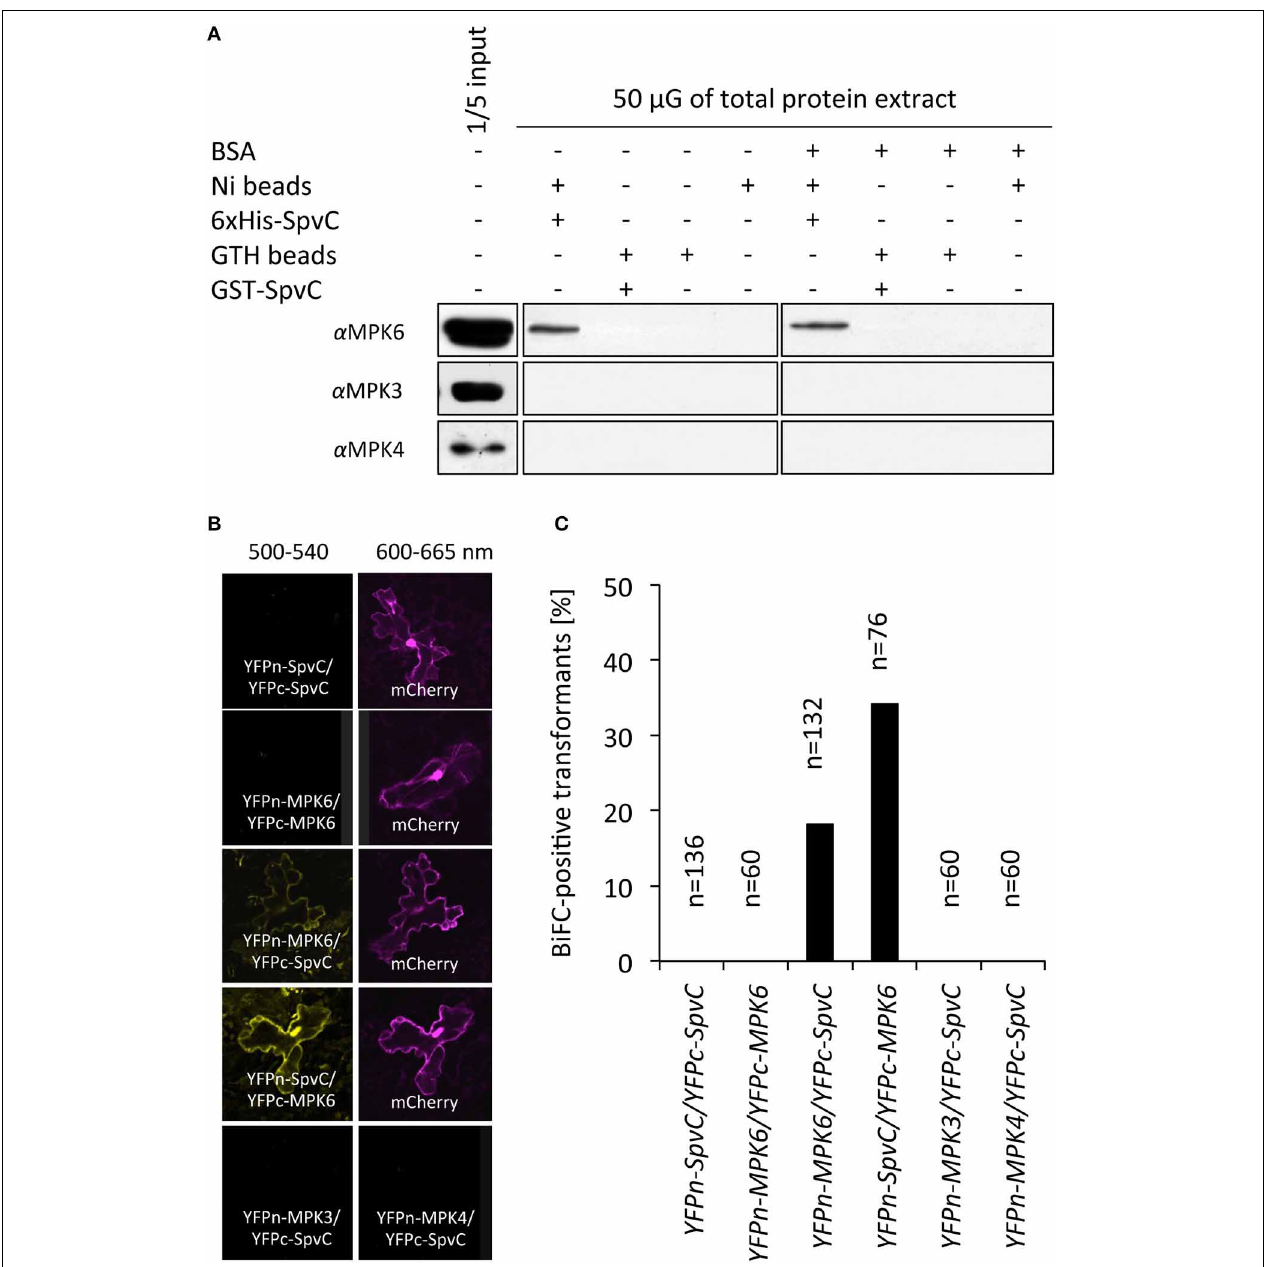
FIGURE 4 | Arabidopsis MPK6 interacts with the SpvC effector. (A) In a pull-down assay, recombinant 6xHis-SpvC or GST-SpvC proteins were co-incubated with total protein extract from Arabidopsis seedlings and Ni- or GTH-coated beads, respectively, as indicated by “ + ”. Anti-MPK6, anti-MPK3, and anti-MPK4-specific antibodies were used to visualize the presence of the respective kinases in Ni- or GTH-binding complexes in an immunoblot analysis. Only MPK6 was detected, indicating a specific binding between MPK6 and 6xHis-SpvC, however not GST-SpvC, proteins. (B) Bimolecular fluorescence complementation (BiFC) assay was performed with full-length